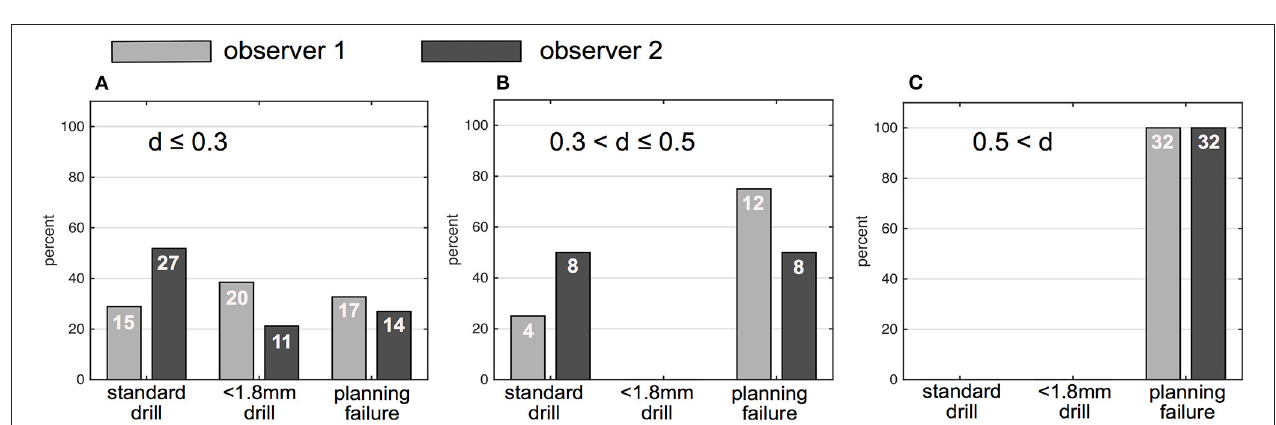
FIGURE 1B | Planning procedures with OTOPLAN. The trajectory path to the middle ear/round window is calculated automatically and safety distances to critical anatomic structures are displayed by the software. Red shading (cochlear segmentation automatically calculated by the software), green shading (bony overhang automatically calculated by the software), yellow shading (facial nerve), dark blue shading (external ear canal), pink shading (ossicles), orange shading (chorda tympani), light blue shading (drill in position of the automated trajectory).